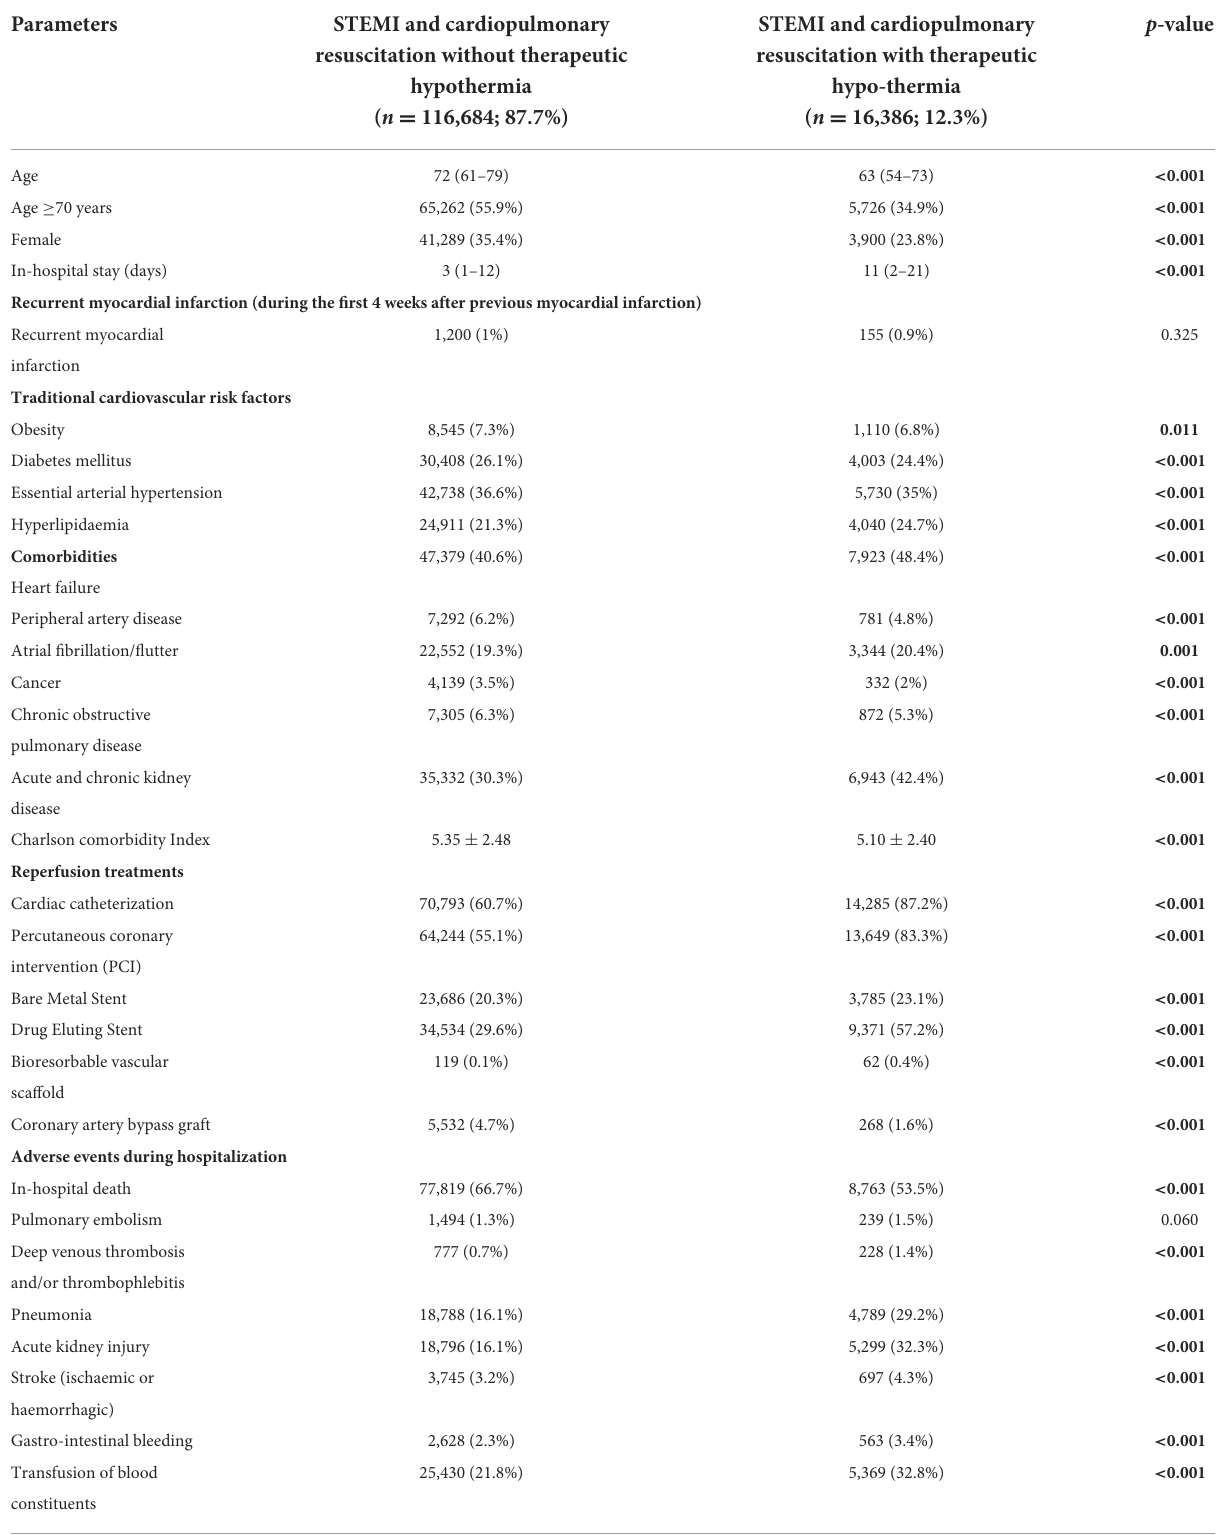
TABLE 1 Characteristics, medical history, presentation, and outcomes of 133,070 STEMI patients with cardiopulmonary resuscitation, stratified for therapeutic hypothermia treatment.